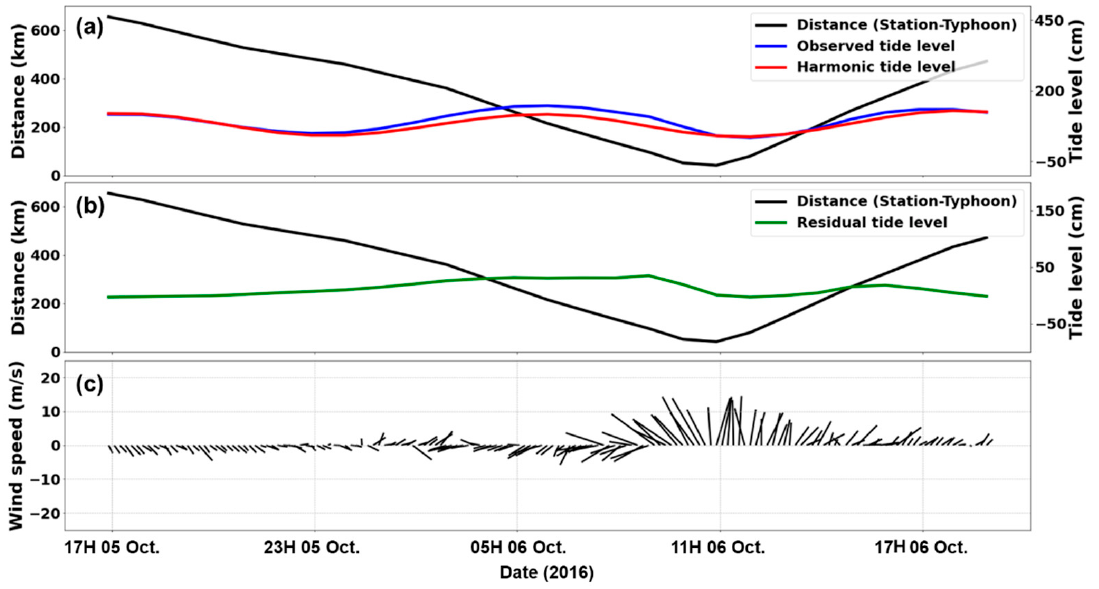
Figure 11. Time-series of observational data from Busan tidal station during Typhoon Kong-Rey. ( a ) Astronomical tide, ( b ) residual tide level, and ( c ) wind components, where direction and length represent wind direction and speed, respectively.